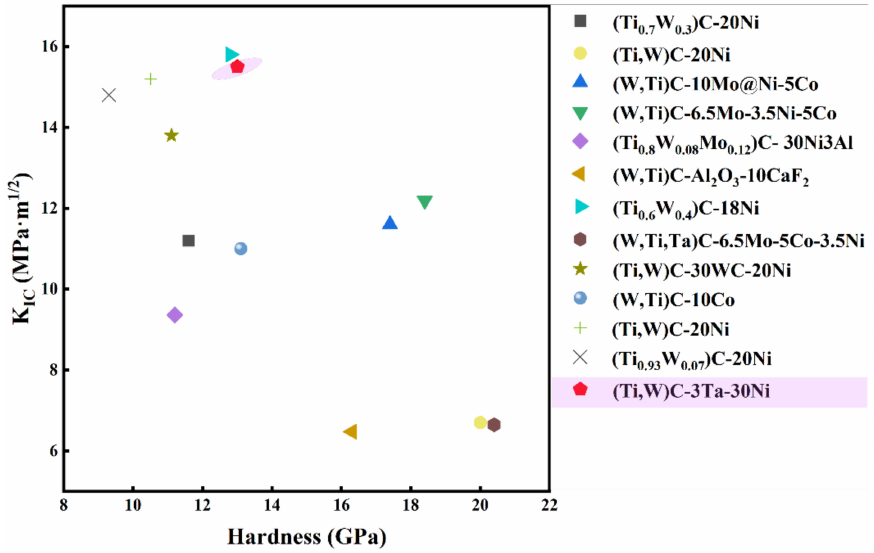
Figure 10. Comparison of (Ti,W)C-3Ta-30Ni cermet prepared in this work with other